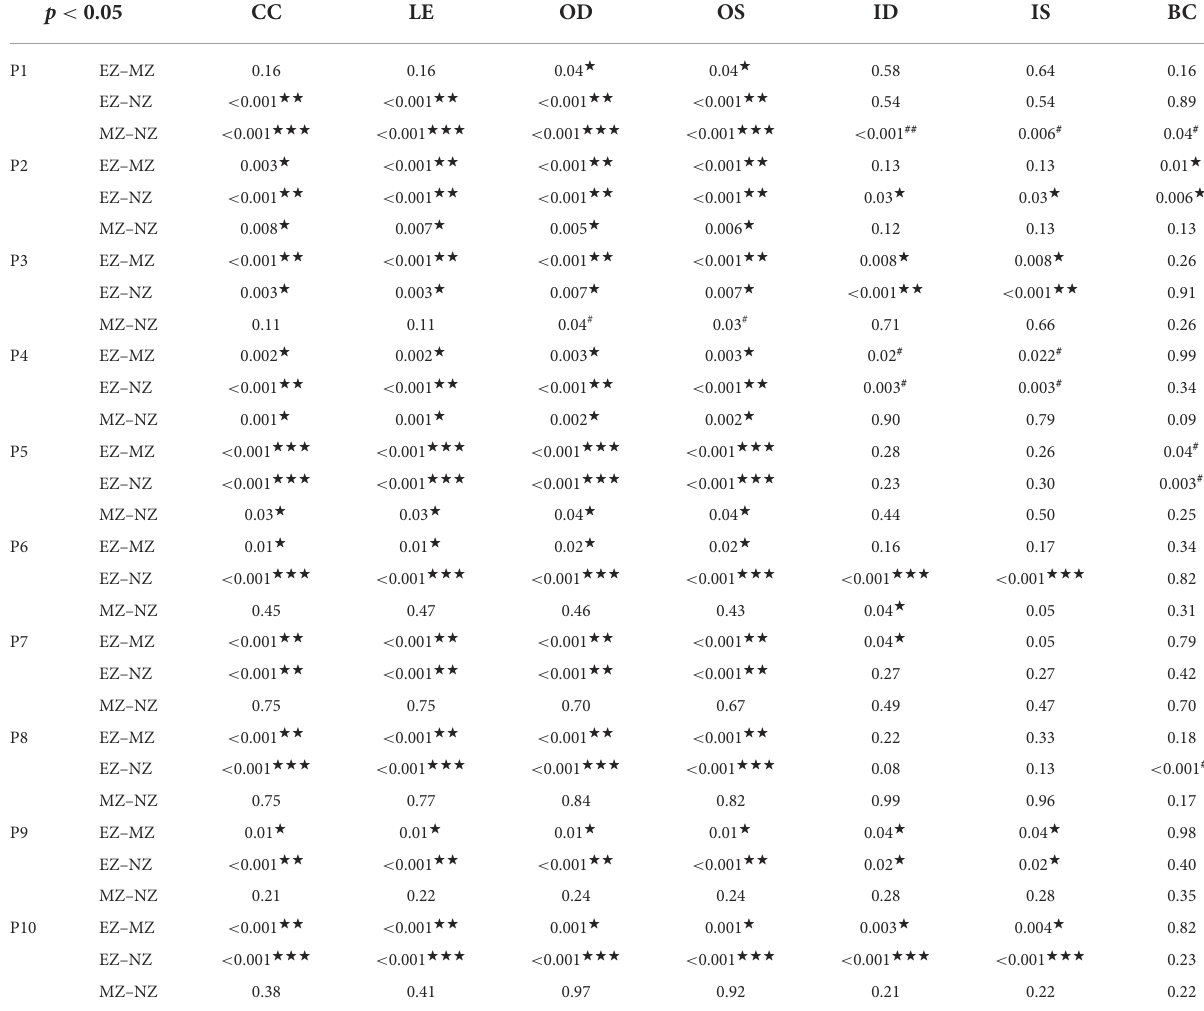
TABLE 1 Mann–Whitney U -test (two–tailed) for comparative analysis between EZ, MZ, and NZ for each